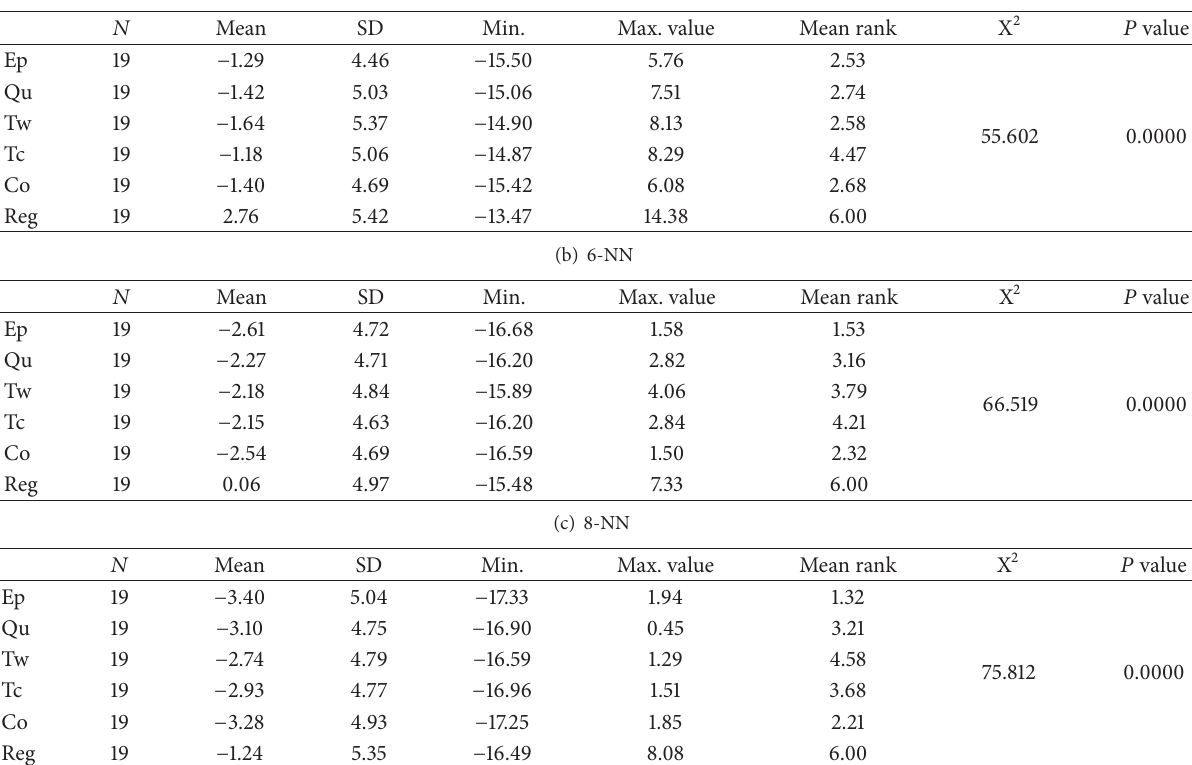
Table 2: Chi-square ( Χ 2 ) test with Friedman method for finding difference among six infilling methods. SD represents standard deviation. 𝑃 value means significance